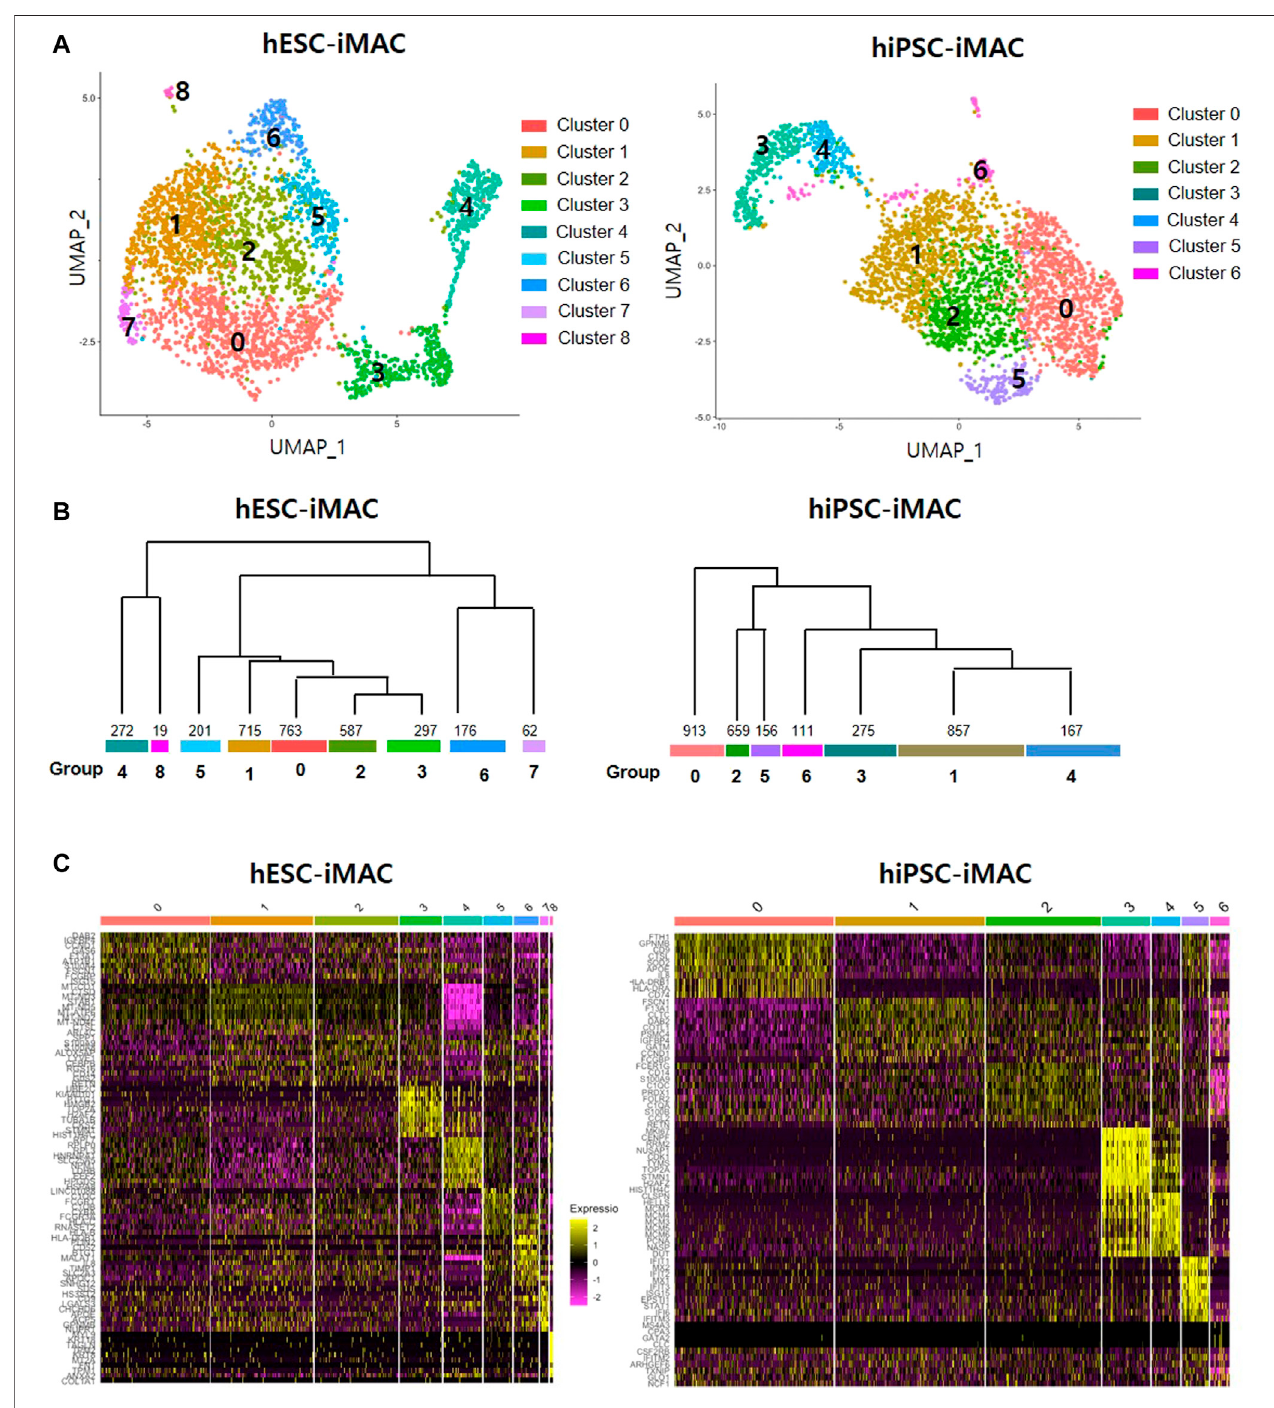
FIGURE2 | Cellular heterogeneity within the fi ltered induced macrophages (iMACs) analyzed bySeurat method. In total, 3,092 hESCderived iMACs (hESC-iMAC) and 3,138 hiPSC derived iMAC (hiPSC-iMAC) were analyzed via two-dimensional UMAP analysis to visualize their similarity. (A) The iMACs were grouped into 6 (hESC- iMAC)and8(hiPSC-iMAC)clusters.Thecolorcodesareasindicated. (B) Thedendrogramshowingassociationsamongclusters.Thebottomofthebranchindicatesthe number of cells in each cluster. (C) Heatmap shows the expression of the top 10 genes of each group.